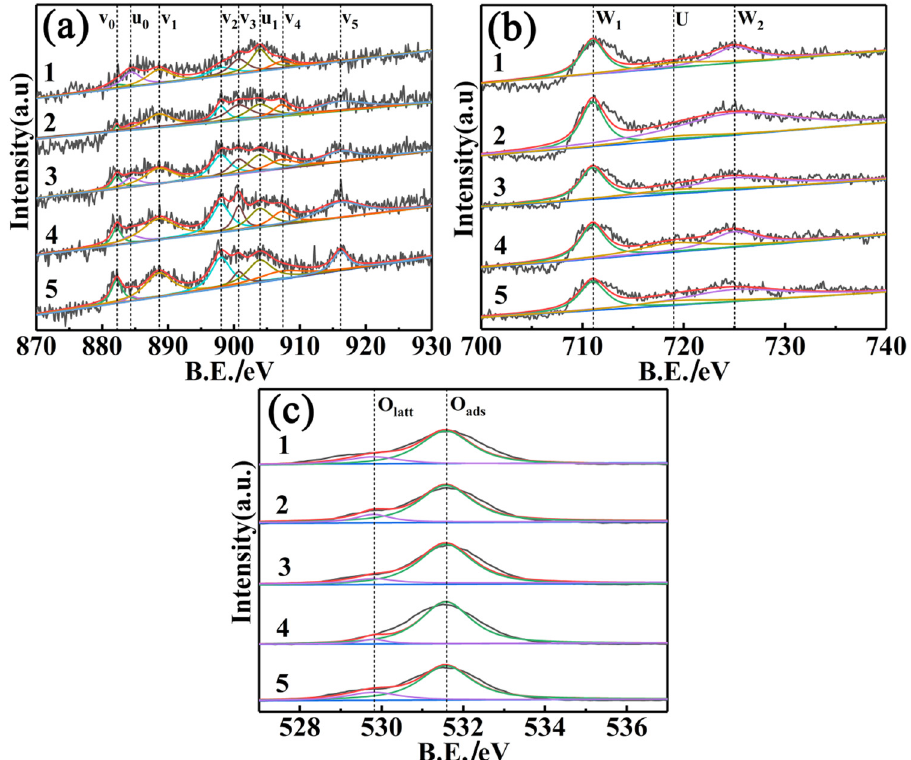
Figure 8: XPS spectra of catalysts: ( a ) Ce 3d, ( b ) Fe 2p, ( c ) O 1